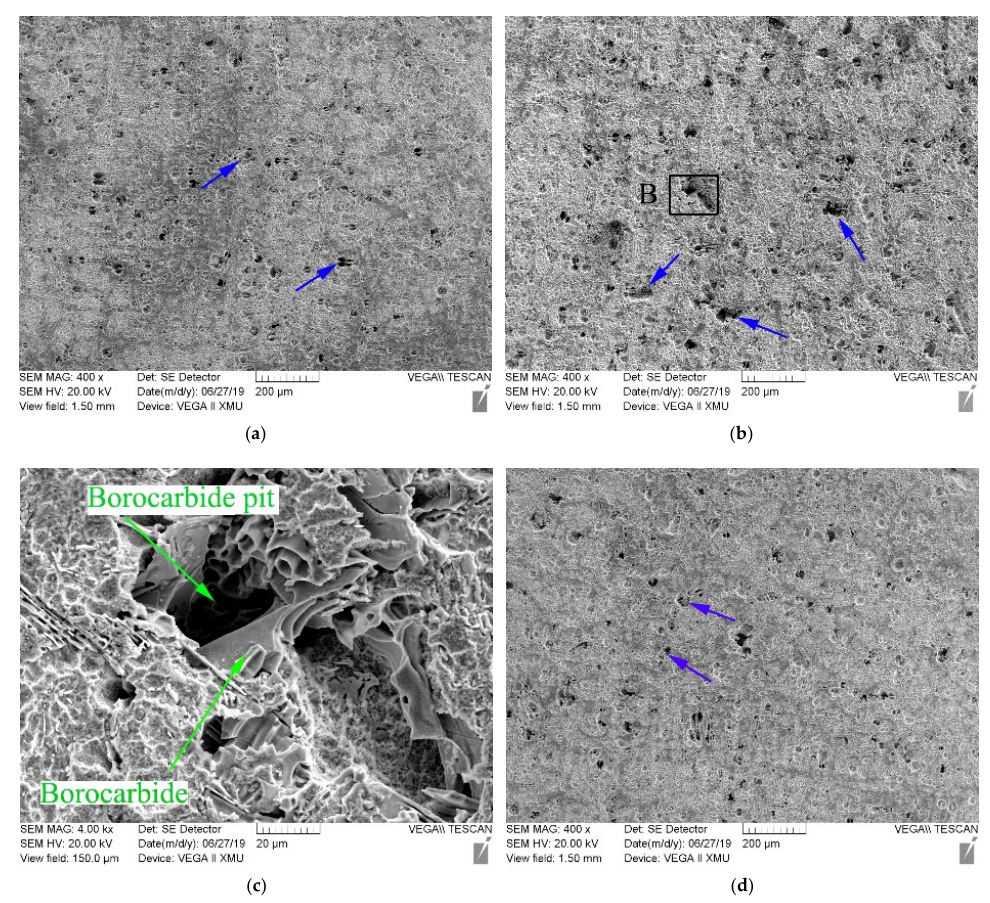
Figure 7. Erosion–corrosion face morphology SEM of boron-bearing stainless steel sample under test condition of impingement angle 45°, and rotating speed 1200 rev·min − 1 : ( a ) displaying erosion–corrosion face morphology; ( b ) displaying the magnified microstructures of A area.